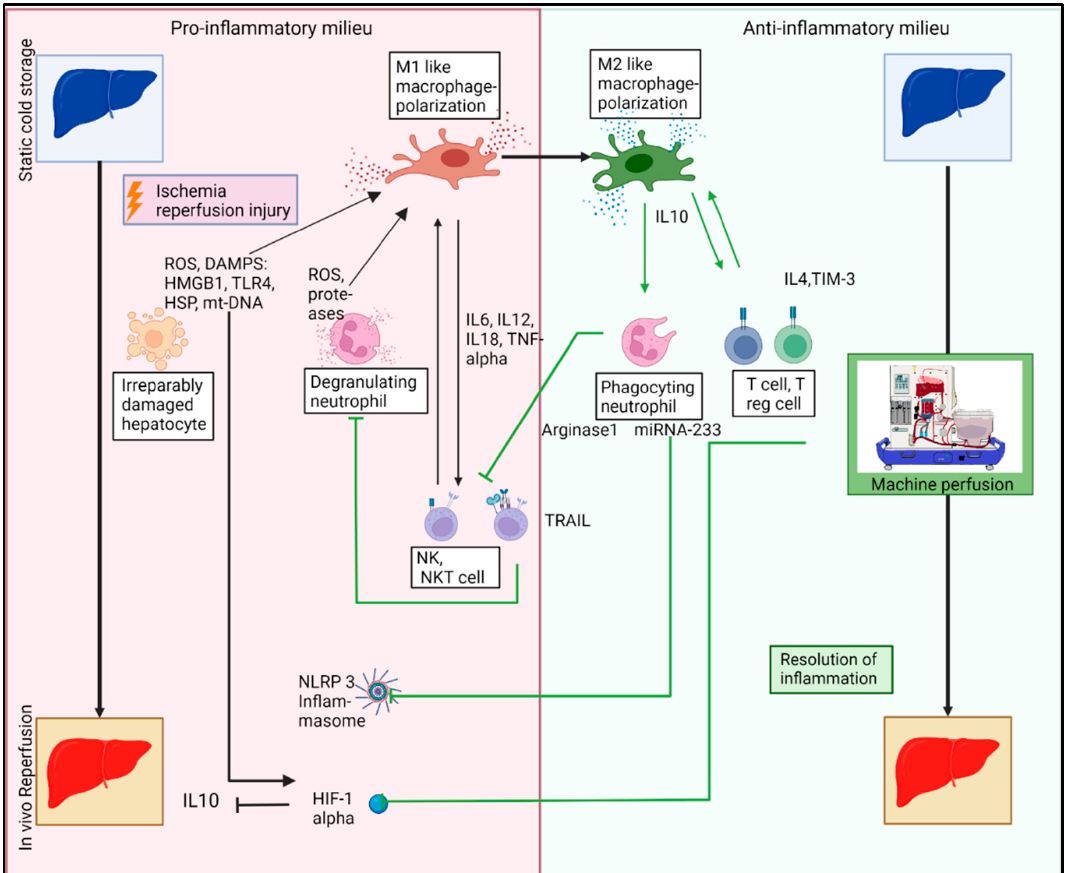
Figure 2. Interaction of innate immune cells during machine perfusion (MP) mitigates hepatic is- chemia reperfusion injury (IRI). During MP, a novel phase of innate immunity is to be established. Macrophages and their subsets can be considered as game changers that drive innate immunity towards an anti-inflammatory milieu. Interleukin 10 (IL10) secreted by M2-like macrophages in- hibit the dynamic change toward M1-like macrophage polarizations. The establishment of an anti-inflammatory milieu affects associated innate immune cells such as neutrophils that clear cell debris of irreversibly damaged hepatocytes together with macrophages. Innate immune cells initially known to act in a primarily pro-inflammatory way were found to promote anti-inflammatory effects as well. MicroRNA-233 secretion by neutrophils inhibits NLR-family-pyrin-domain-containing 3 (NLRP3) inflammasome formation. Natural killer (NK) cells and natural killer T (NKT) cells inhibit counteract neutrophils via the tumor-necrosis-factor-related apoptosis-inducing ligand. Moreover, MP mediated the amelioration of hypoxia-inducible factor 1 (HIF1)-alpha, reducing proinflammatory pathways. The interlink between M2-like macrophage polarizations and regulatory T (T reg) cells through a secretion of transforming growth factor-beta and IL10 supports macrophage-mediated anti-inflammatory capacities and T-cell-mediated immune tolerance. (Created with BioRender.com, accessed on 24 September